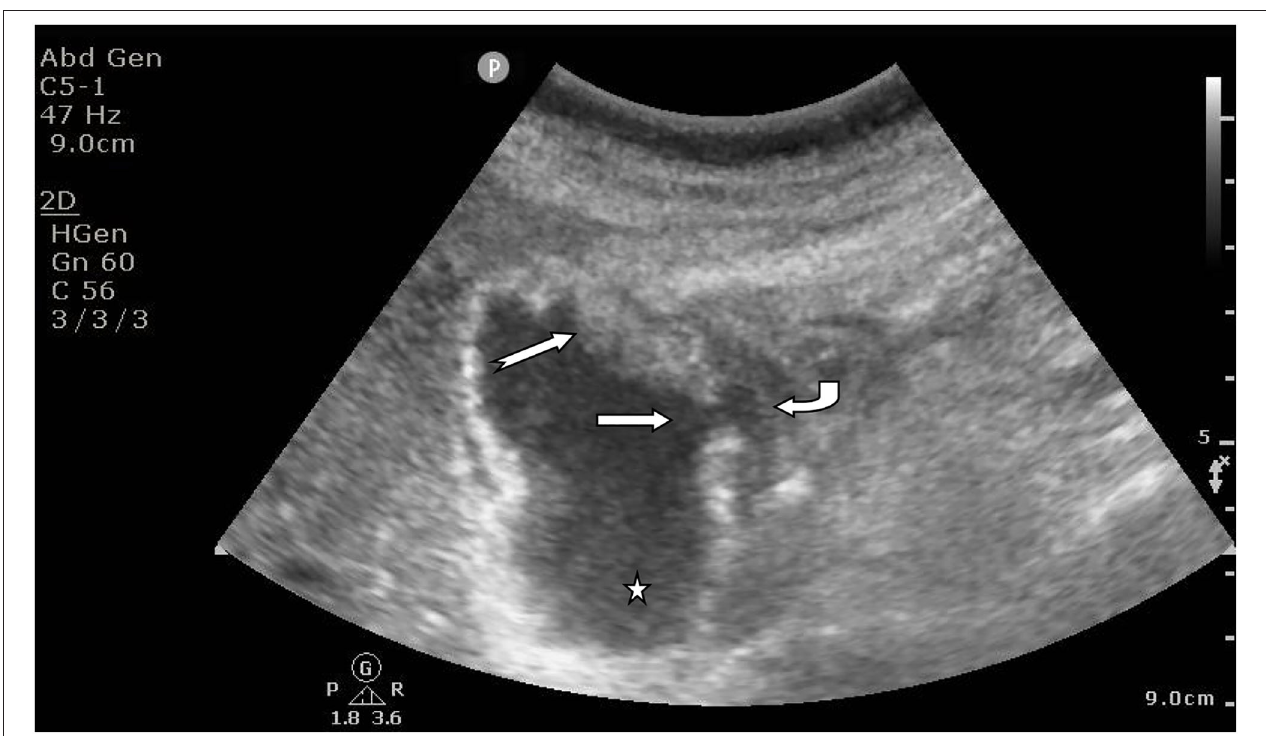
FIGURE 2 | Supine examination of a male patient showed increased gallbladder volume, interrupted continuity of the gallbladder wall, perforation (straight arrows), uneven thickening of the gallbladder wall with mucosal layer abscission (swan-tail arrows), cholestasis (pentagonal star), and effusion around the gallbladder (curved